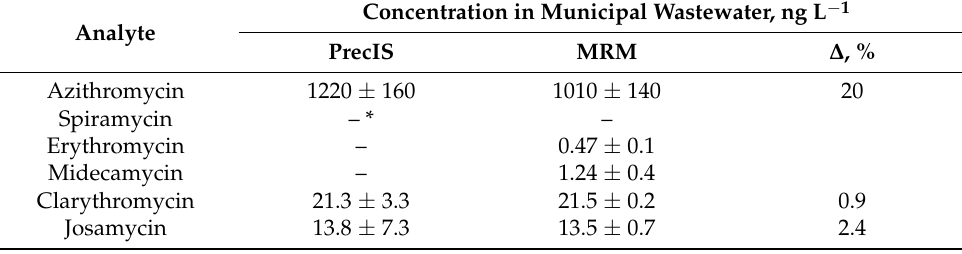
Table 3. Levels of six target macrolides in municipal wastewater determined by HPLC-MS/MS in PrecIS and MRM detection modes.